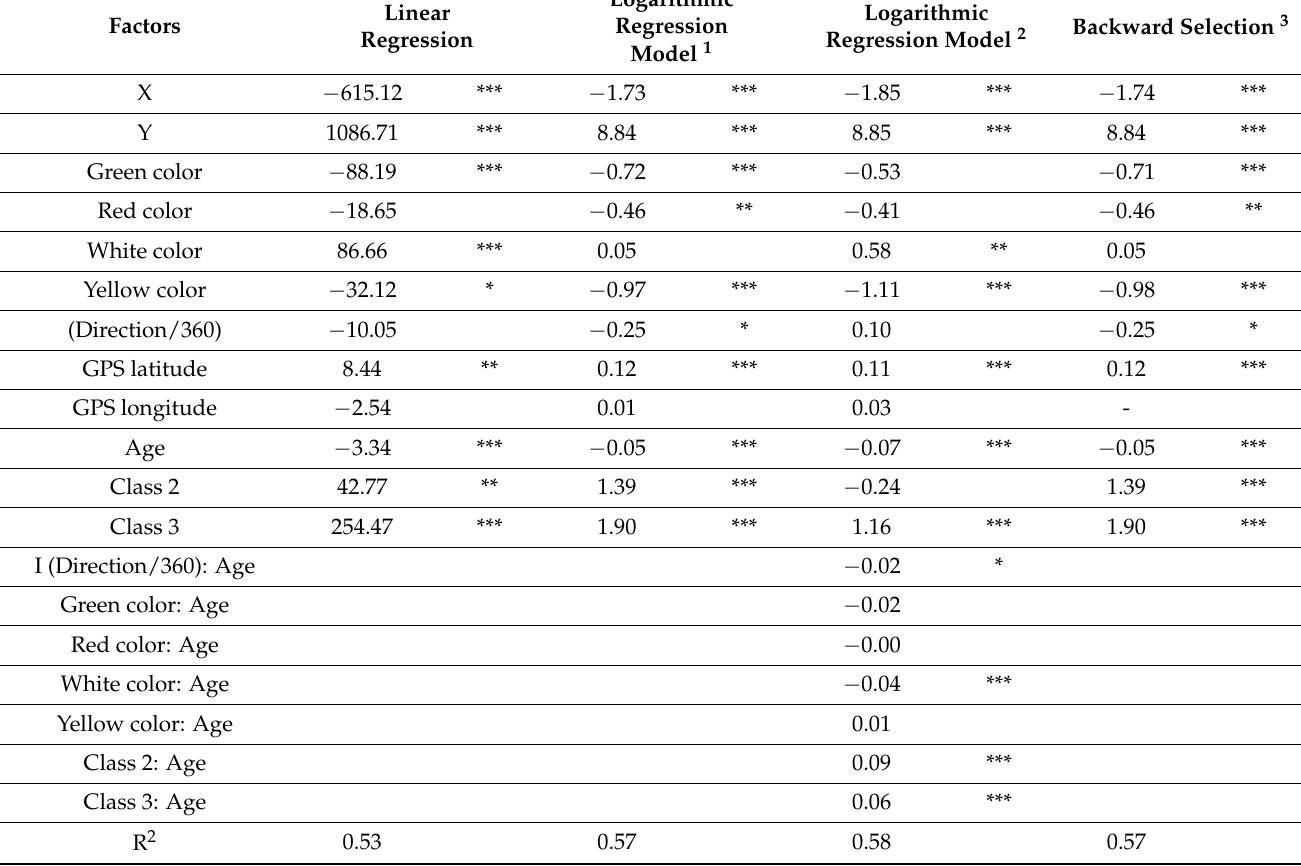
Table 3. The relationship between retroreflectivity and other factors in the VTI data. Linear Regression